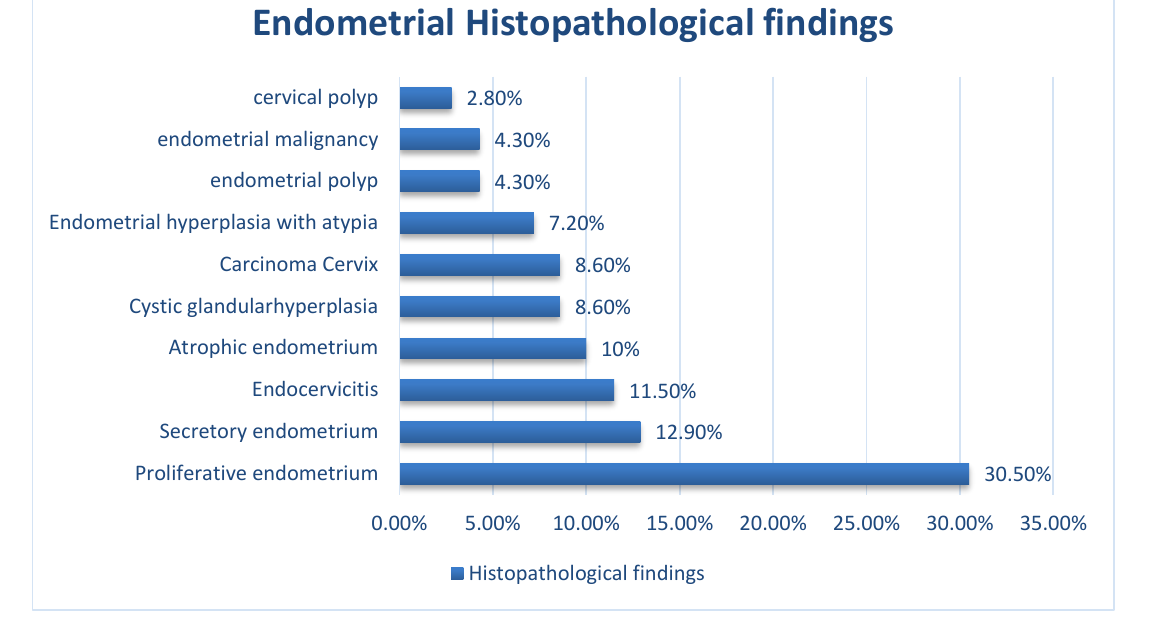
Fig. 4. The endometrial histopathological findings of study